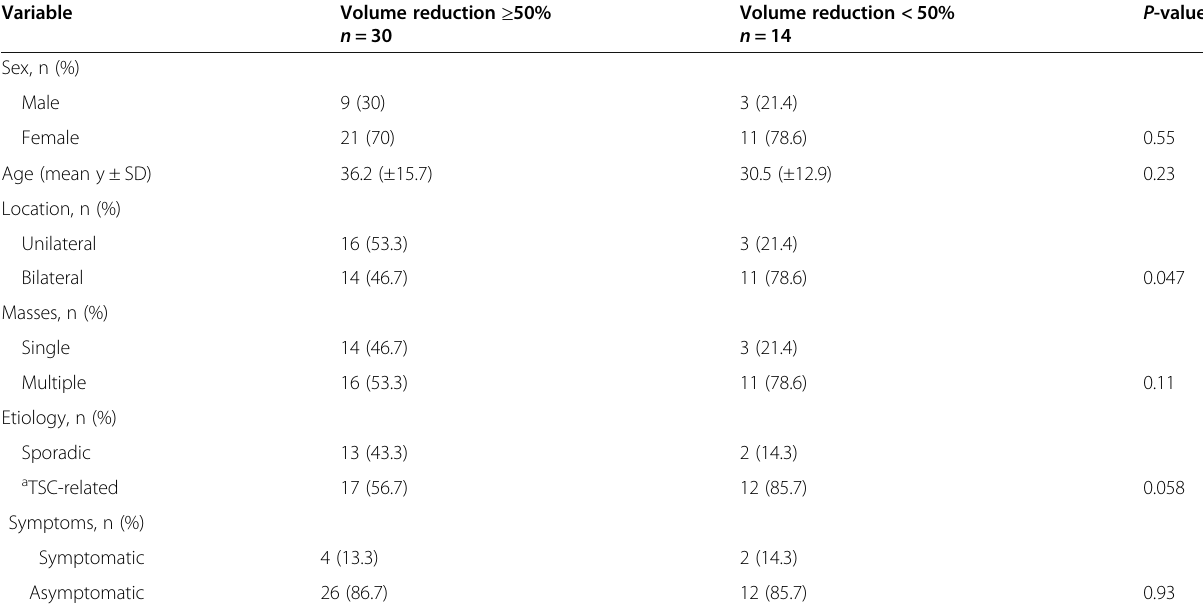
Table 1 Patients ’ background characteristics